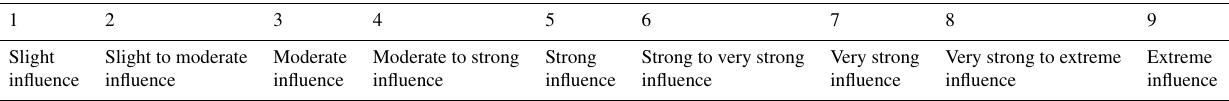
Table 4. Table of influence for indicator weighting, ranging from slight influence of an indicator (1) to extreme influence (9) (modified from Saaty,